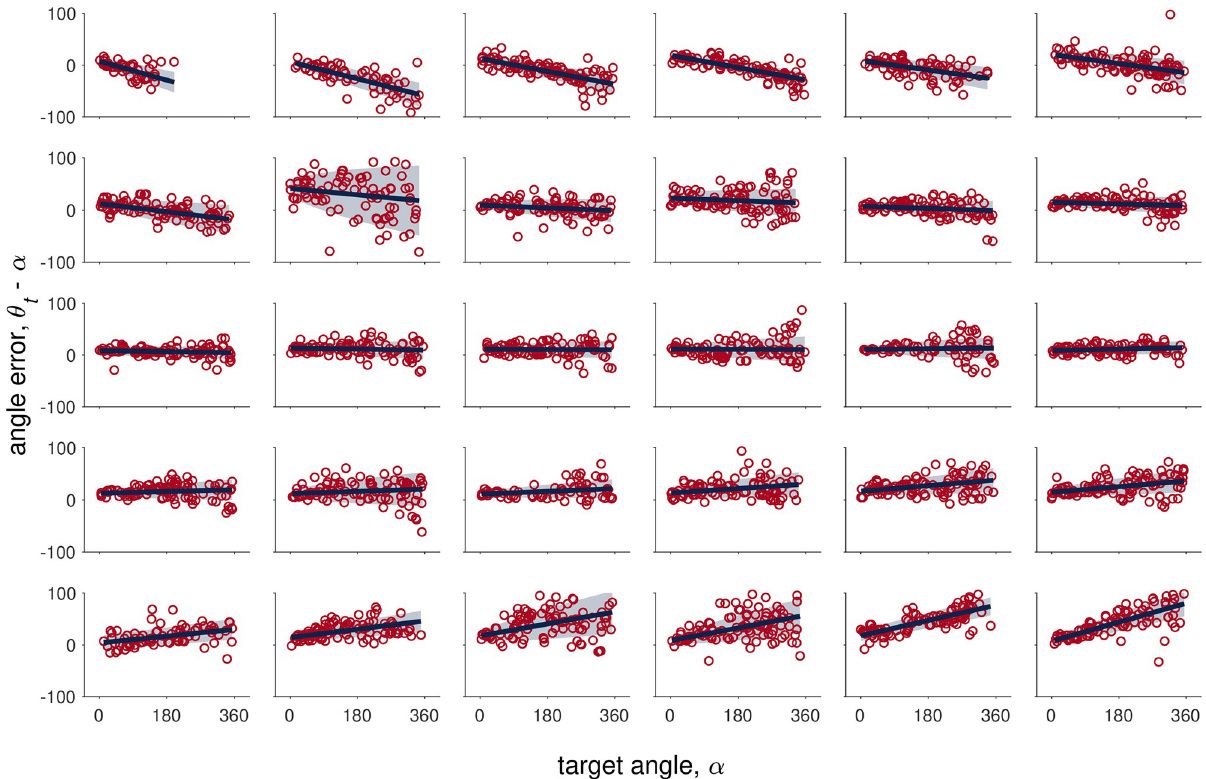
Fig 7. Error vs target angle for the No Feedback condition. Each plot corresponds to data from one participant and plots are ordered from most negative slope (top left) to most positive slope (bottom right). The red circles correspond to human data, the solid blue to the mean error from the Path Integration model fit, and shaded blue area to the mean ± standard deviation of the error from the Path Integration model fit.